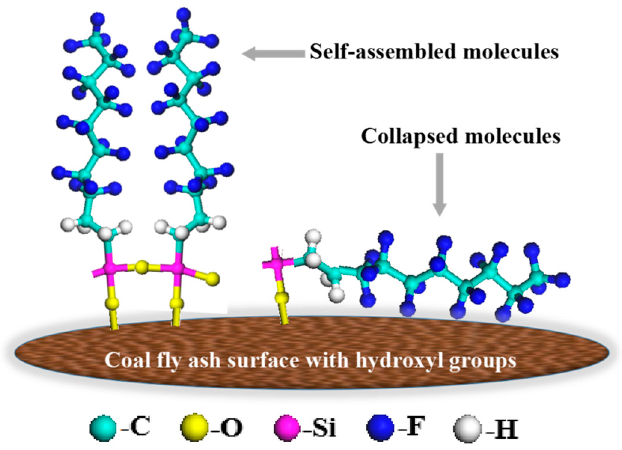
Figure 10. HFDS monolayer on the surface of coal fly ash with hydroxyl groups [29]. (Left: well-oriented or self-assembled, Right: collapsed molecules).